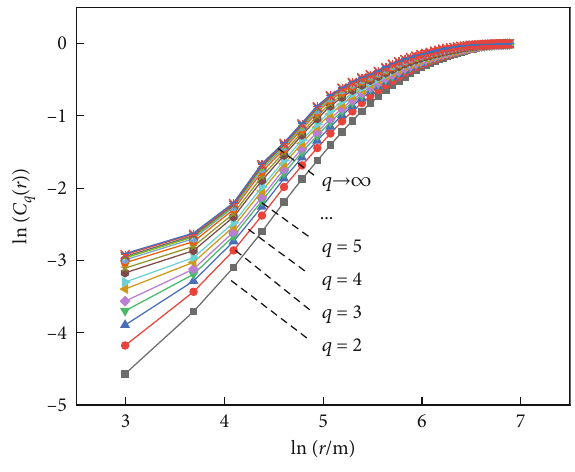
Figure 6: lg N - M curve of magnitude and frequency